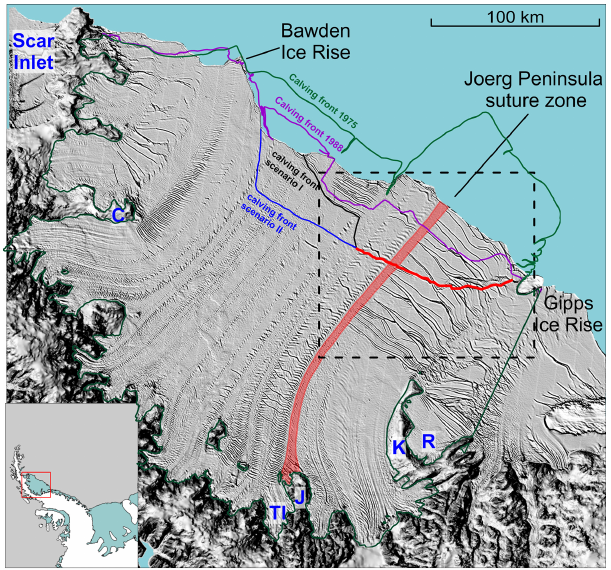
Figure 1. Overview of the Larsen C Ice Shelf in late 2014 show- ing the contemporary location of the developing rift (red line), and a selection of previous and predicted future calving fronts. Back- ground image is MODIS Aqua, 3 December 2014 for the ice shelf and a shaded relief digital elevation model of the Antarctic Penin- sula mountains: Cook et al. (2012). Geographic features of interest are marked (TI – Trail Inlet, K – Kenyon Peninsula, R – Revelle Inlet, J – Joerg Peninsula, C – Churchill Peninsula) and the dashed box shows the extent of Fig. 2. The highlighted flow line indicates the location of the Joerg Peninsula suture